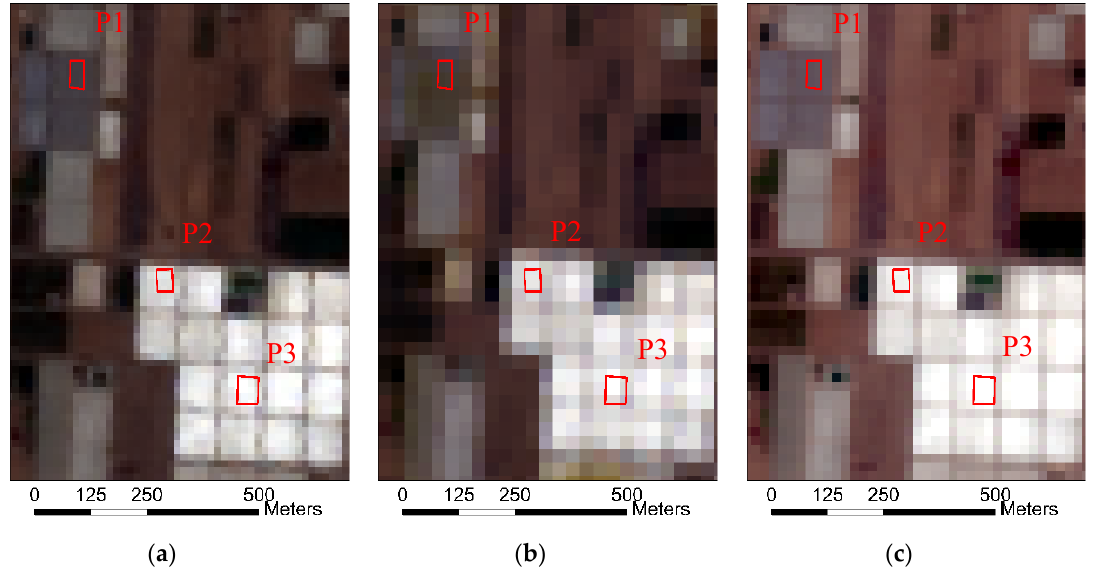
Figure 2. Location of three of the polygons (P1, P2 and P3) digitized in Agadir (SS2): ( a ) L8 PANSH,